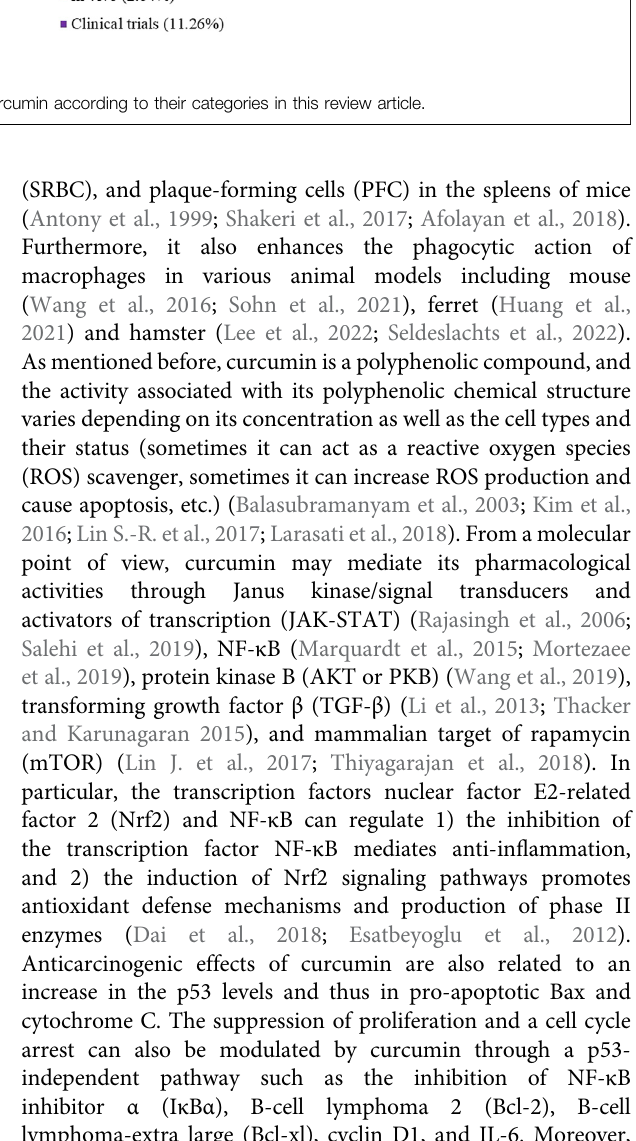
Frontiers in Pharmacology |